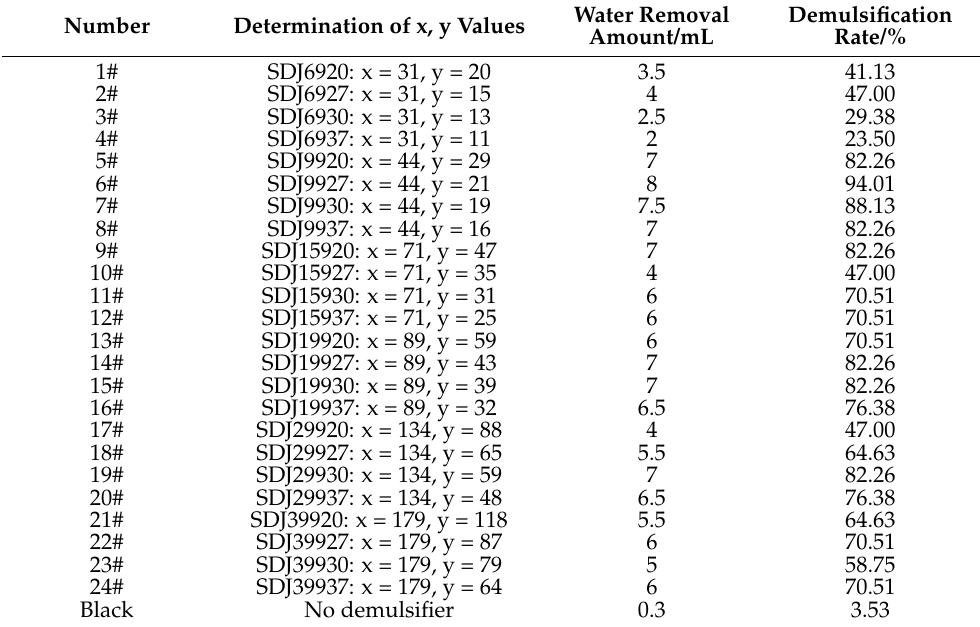
Table 4. The actual water removal amount of demulsifiers (120 min, 100